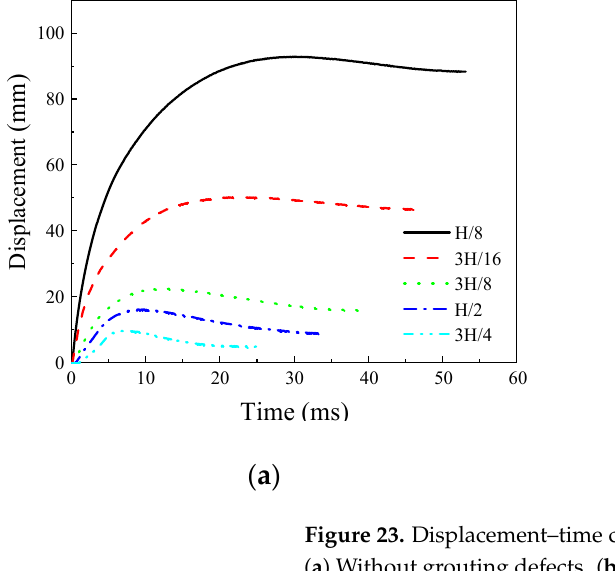
decreases rapidly, the equivalent T3D2 truss unit simulating the sleeve specimen fails, the sleeve at the bottom of the blasting surface of the shear wall is damaged by reinforcement pulling out, and the connection of the shear wall support is severely damaged. Figure 24 shows that the difference between the peak displacements of the wall with and without defects increases with the decrease in the distance from the explosion point. It is verified that the grouting defects have a significant impact on the out-plane stiffness of the prefab- ricated shear wall. Under the action of the explosion load, the closer to the explosion point, the more obvious the influence of grouting material defects on the wall stiffness. 200 400 600 800 1000 1200 1400 1600 1800 2000 2200 020406080100 120 D i s p l ace m e n t ( mm ) Explosive distance (mm) With 10% grouting defects Without grouting defects Figure 24. Peak displacements of the shear wall with different explosive distances. 5. Conclusions and Outlook In this paper, the construction method of a three-dimensional random defect model for grouting materials developed based on the ABAUQS script is used to simulate and verify the reinforced grouting sleeve specimens with defects and is applied to the research on the anti-explosion performance of the prefabricated shear wall with defects. The fol- lowing beneficial conclusions are obtained, and future development suggestions are given: